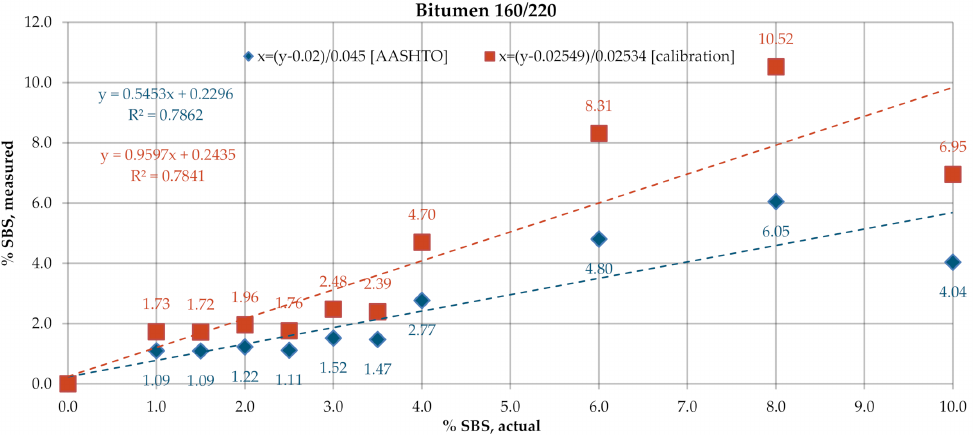
Figure 9. SBS contents in bitumen 160 / 220, ATR.